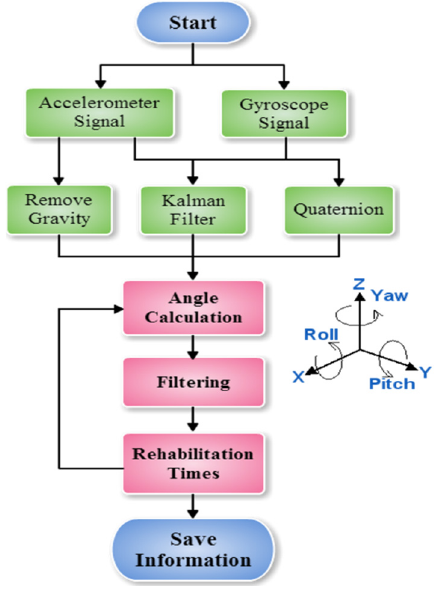
Figure 5. Proposed system flowchart.